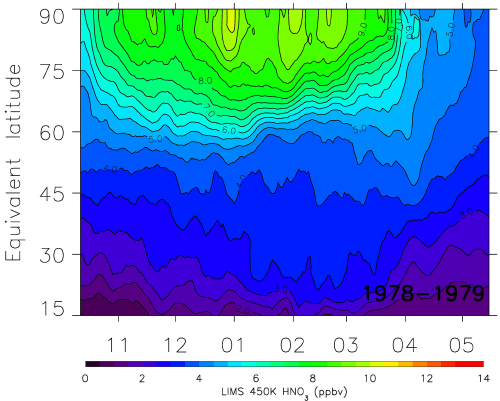
Figure 18. As in Fig. 16, but for ozone (CI is 0.2ppmv).